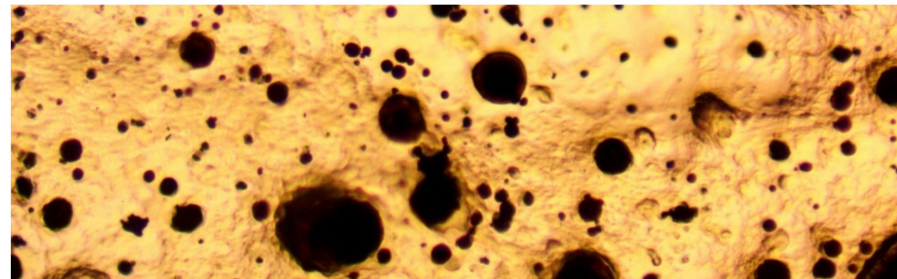
Figure 4. Cu 0 particles (dark color), embedded in resin to demonstrate the multi-modal size distribu- tion. Transmitted light, field of view = 0.1 mm (100 microns).